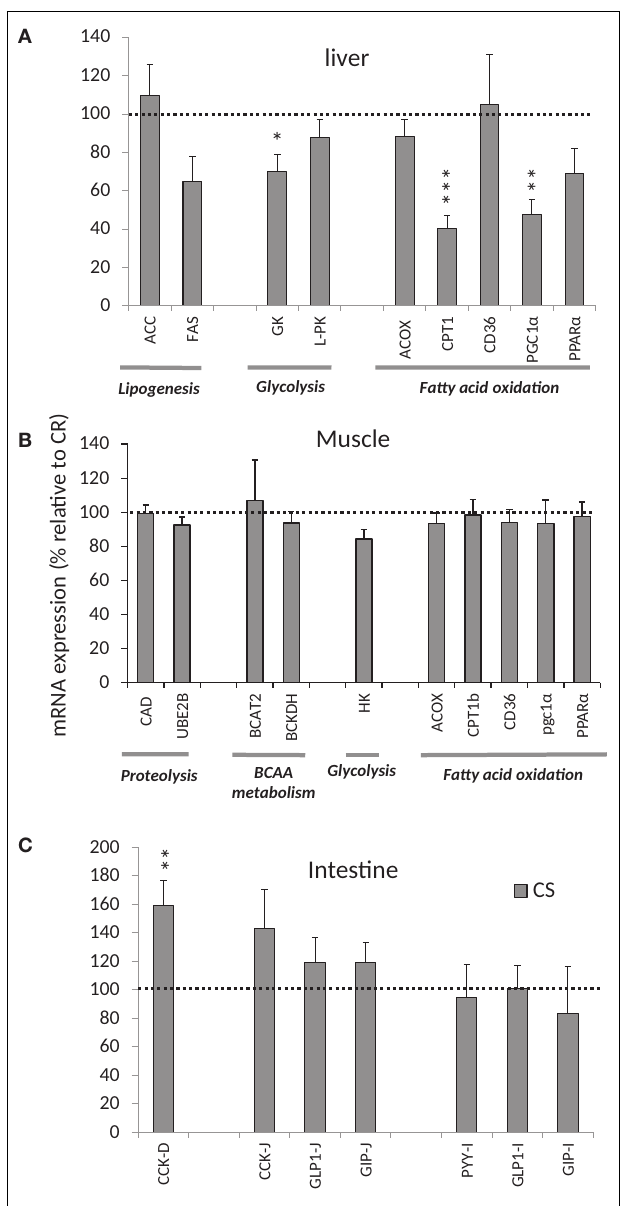
FIGURE 5 | mRNA expression relative to mRNA expression in CR rats . (A) mRNA expression for enzymes/transporters involved in lipogenesis, glycolysis, and FFA oxidation in the liver, (B) mRNA expression for enzymes/transporters involved in proteolysis, BCAA metabolism, glycolysis, and FFA oxidation in muscles, (C) mRNA Expression of peptides involved in satiety signaling in the intestine. * P < 0.05, ** P < 0.01, *** P < 0.001. See Table 2 for abbreviations.